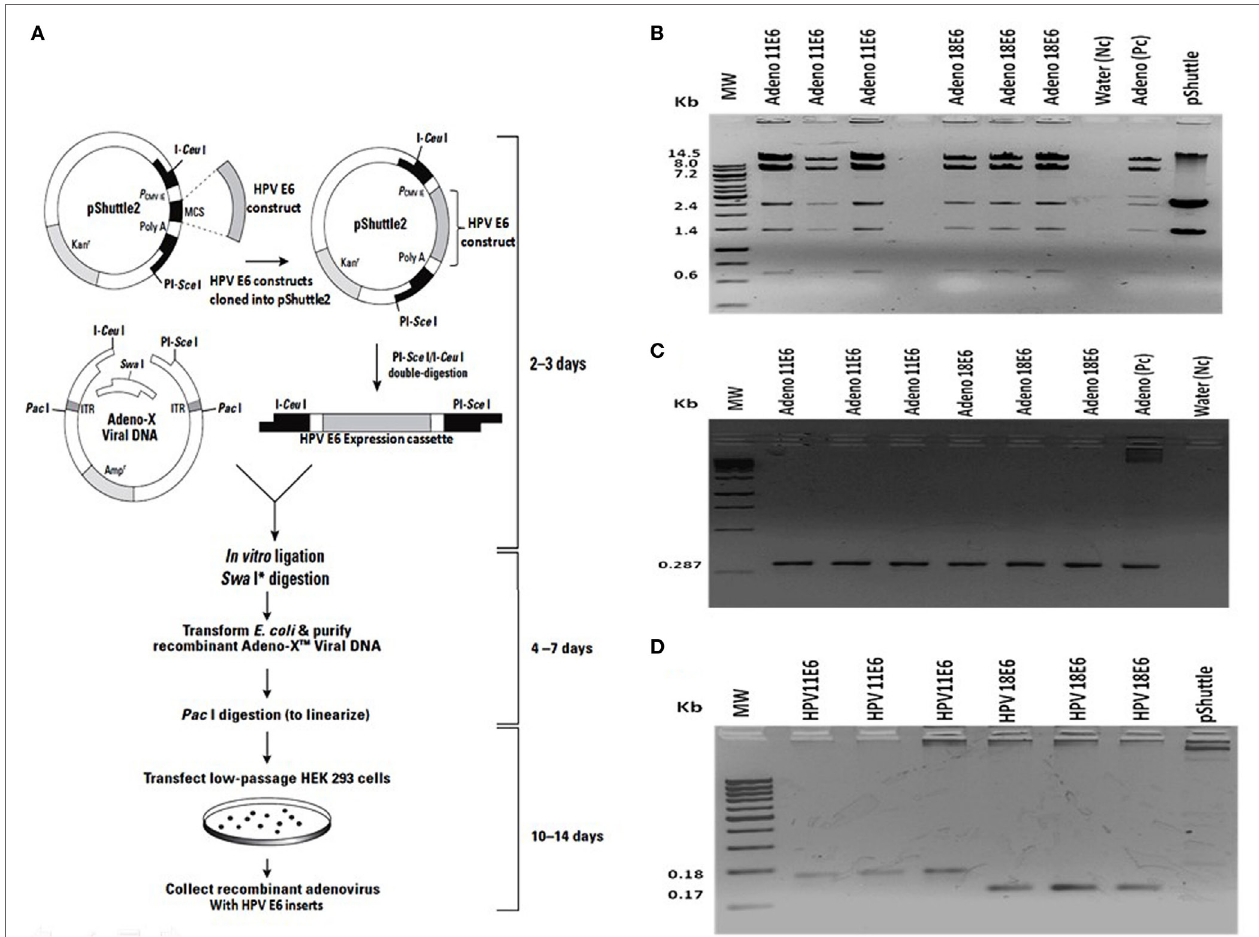
FigUre 1 | Construction of recombinant adeno-E6 vectors. (a) The human papillomavirus (HPV) genes were removed from pcDNA3.1 and cloned into Adeno X as outlined (Image modified from Clontech Labs., Adeno-X™ Expression System 1). (B) Verification of cloning of the HPVE6 expression cassette by digestion of the constructs, an Adeno-X positive control (Pc) and the pShuttle2 vector negative control (Nc) with XhoI. (c) Verification of recombinant Adeno-HPVE6 constructs by PCR with the Adeno-X forward and reverse PCR primers that specifically amplifies a 287-bp sequence spanning the I Ceu I ligation site. (D) Verification of HPV E6 constructs using HPV11E6 and HPV18E6 specific primers with pShuttle as a Nc. In each case, three different clones of each construct were selected for analysis (B–D)